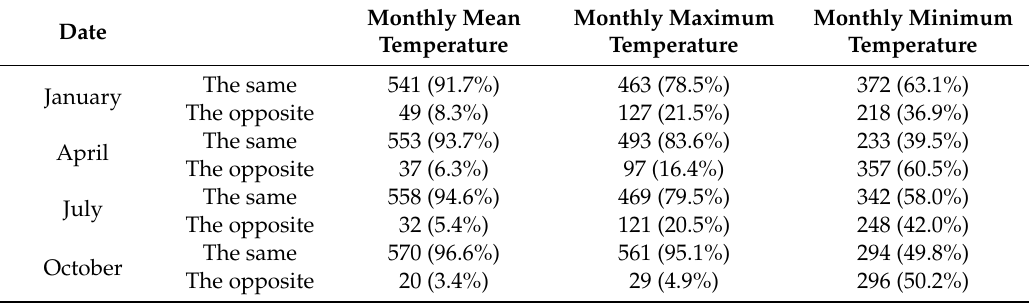
Table 2. The number and percentage (in bracket) of the sites where the observed and gridded monthly data are with the same climate trends (OGSP index) and opposite climate trends (OGOP index) in mainland